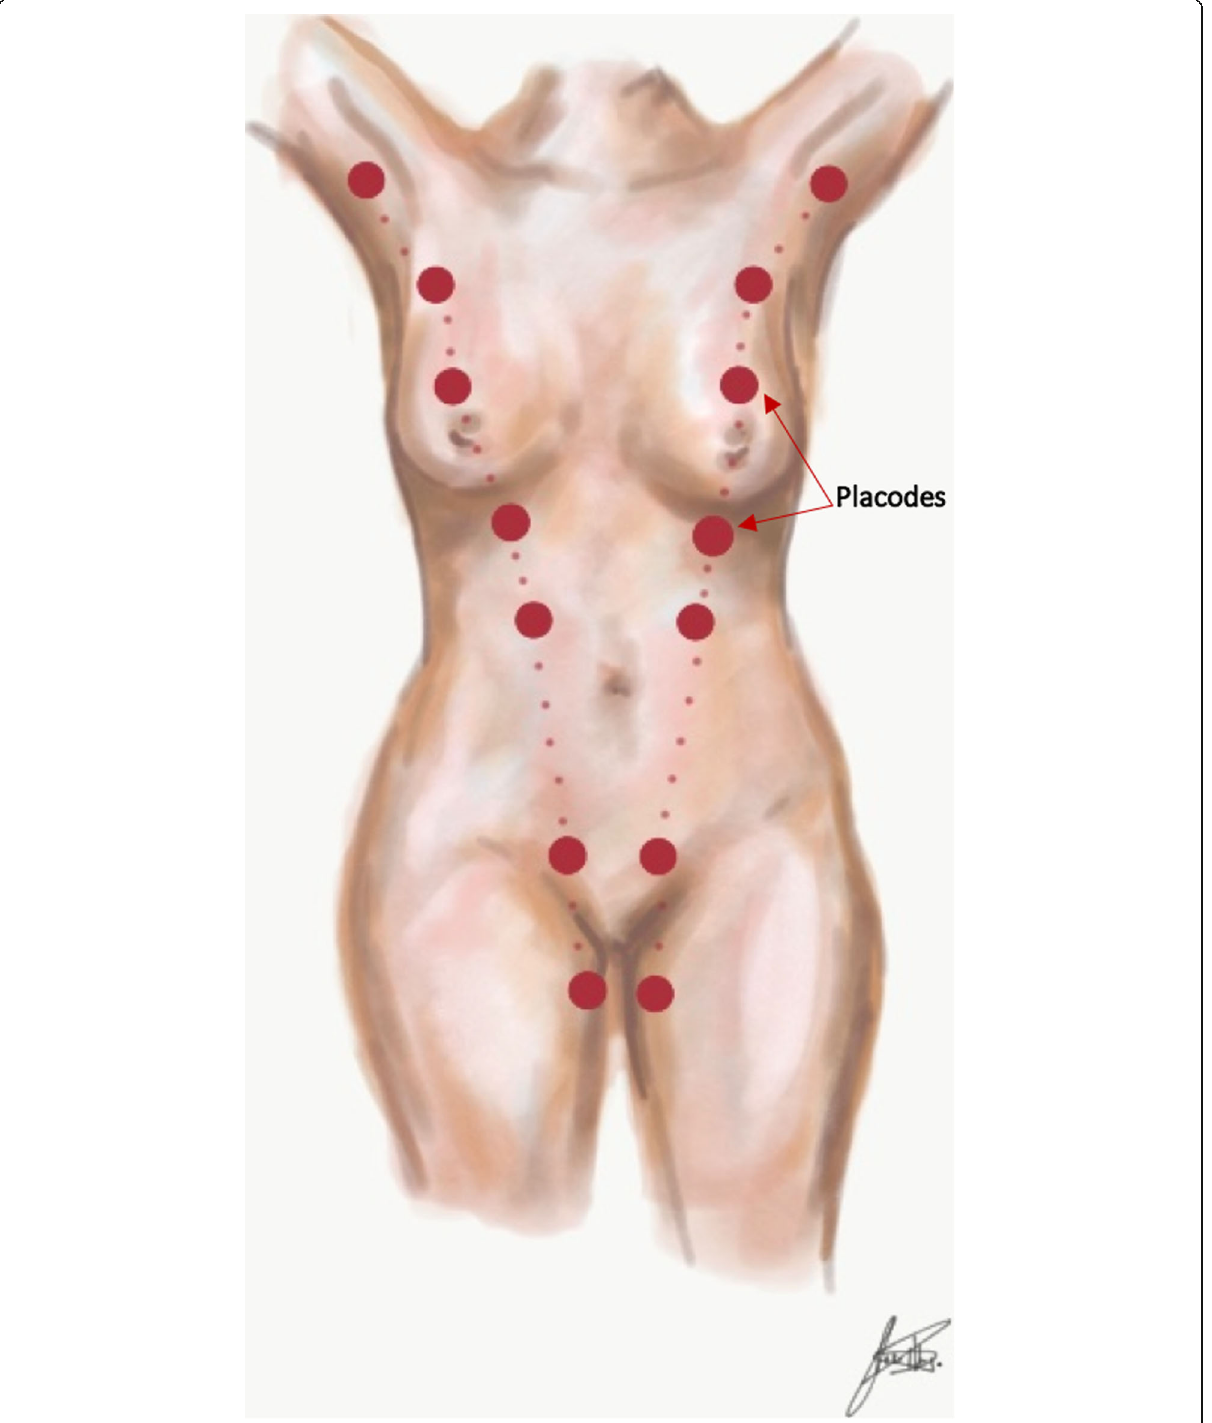
Fig. 3 Milk lines. Placodes form along the milk lines, which extend from the axillae to the inguinal region